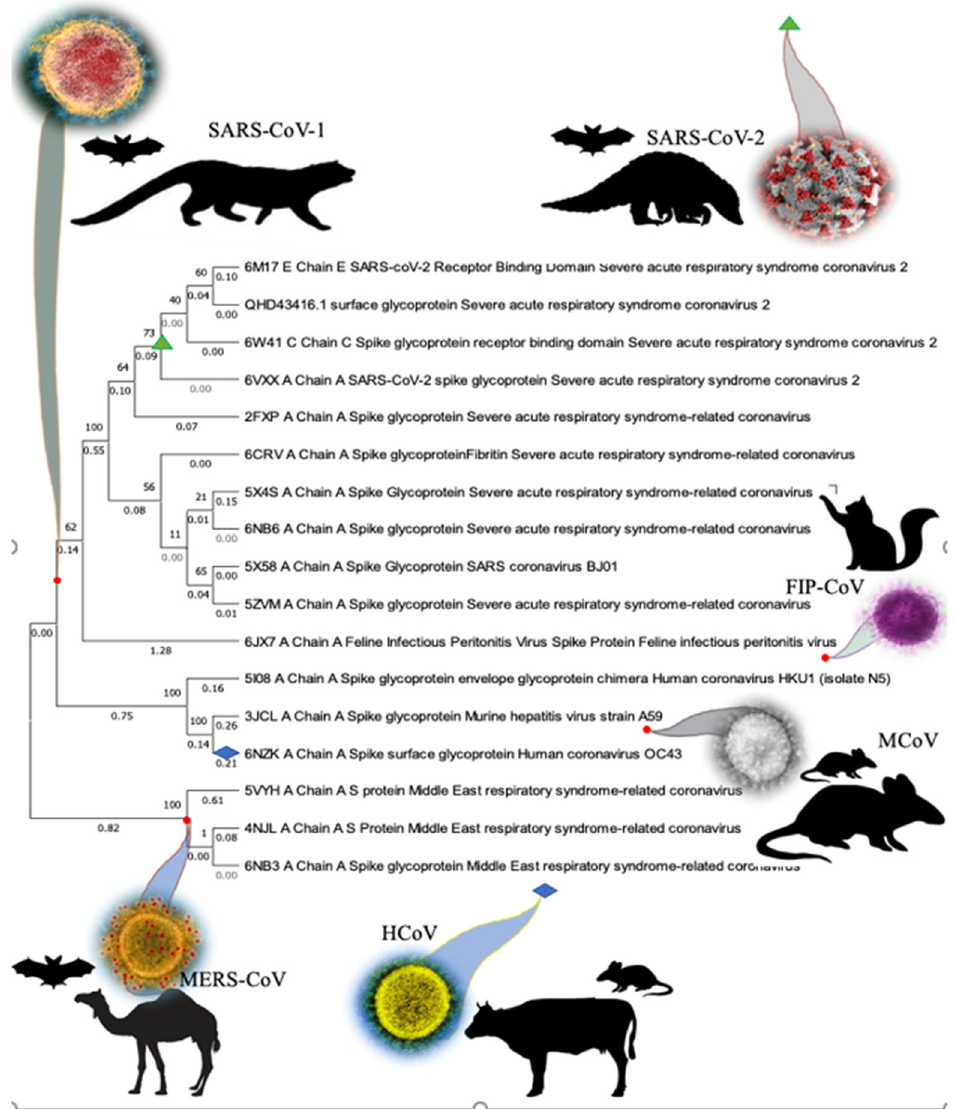
Figure 1. The evolutionary tree was constructed based neighbor-joining and BIONJ algorithms using MEGA 6.0. The topological stability of the NJ tree was achieved by running 100 bootstrapping replications. Bootstrap values (%) are indicated by numbers at the nodes and the length of the branch (represents the evolutionary time between two nodes). This analysis involved 17 amino acid sequences.